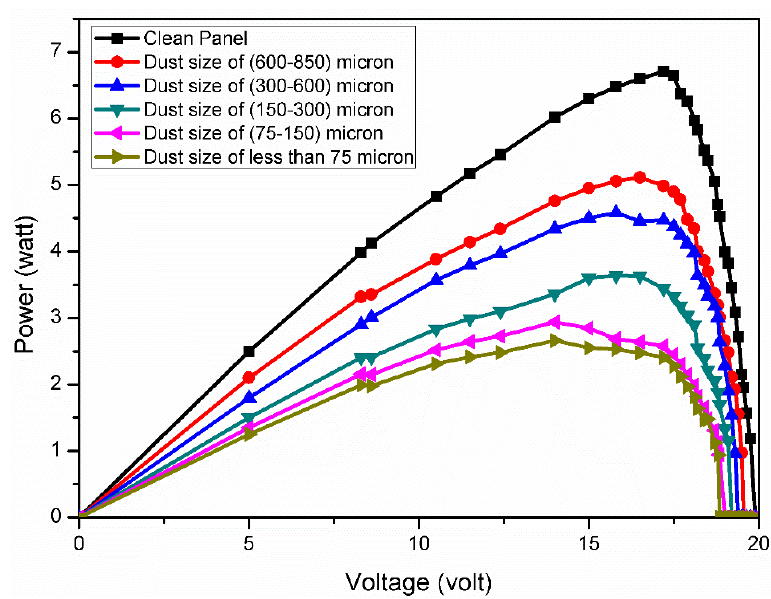
Figure 13. P-V curves of the solar PV panel for different dust size.